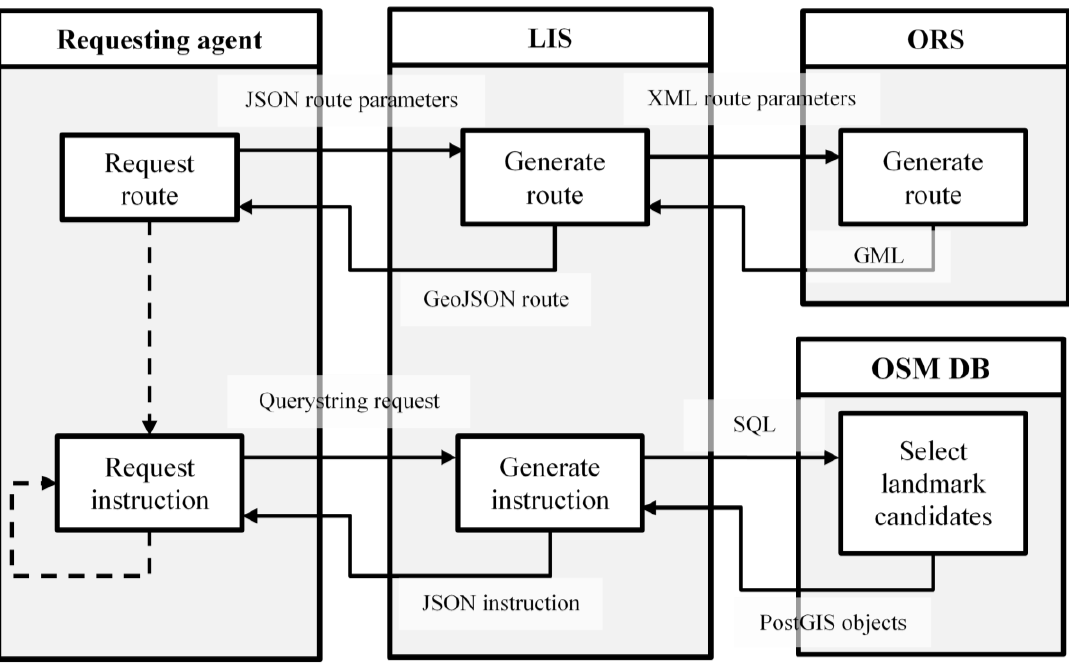
Figure 4. Request flow of the navigation service. LIS, Landmark Identification Service; ORS, OpenRouteService.